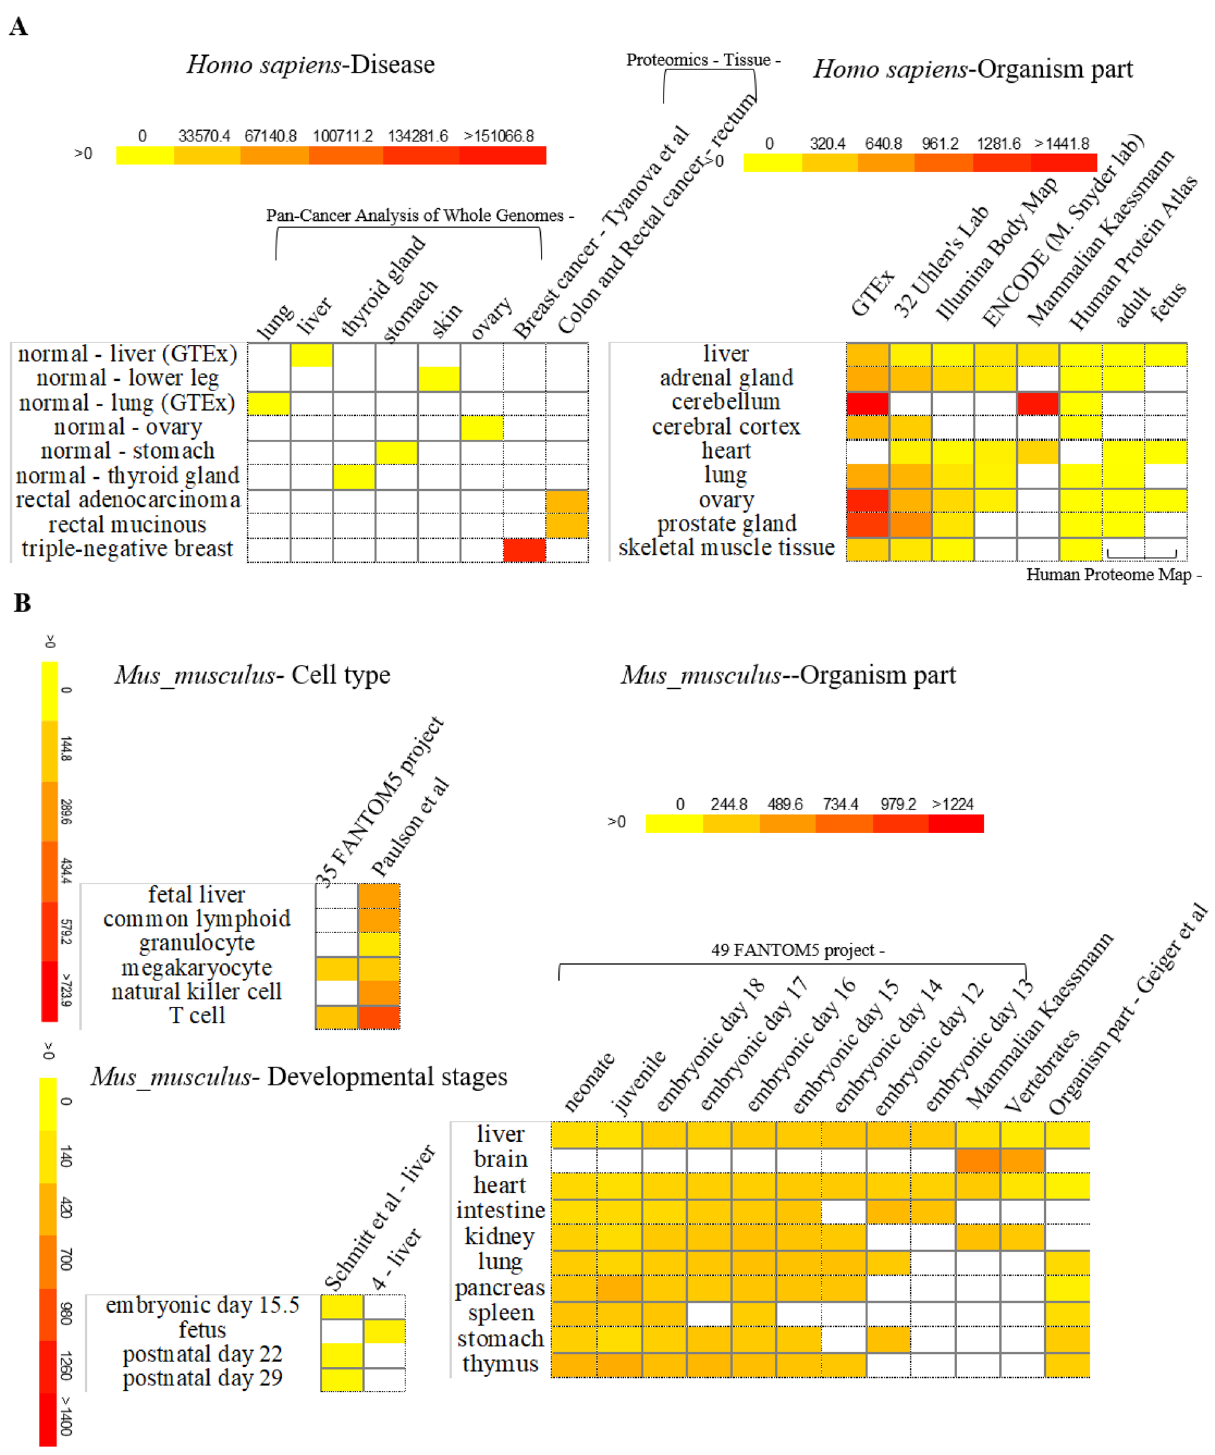
Figure 5. Expression of U1-70K in model organism Homo sapiens and Mus musculus . ( A ) Selected expression profile of human U1-70K gene related to human diseases and organism part is presented in heatmaps. ( B